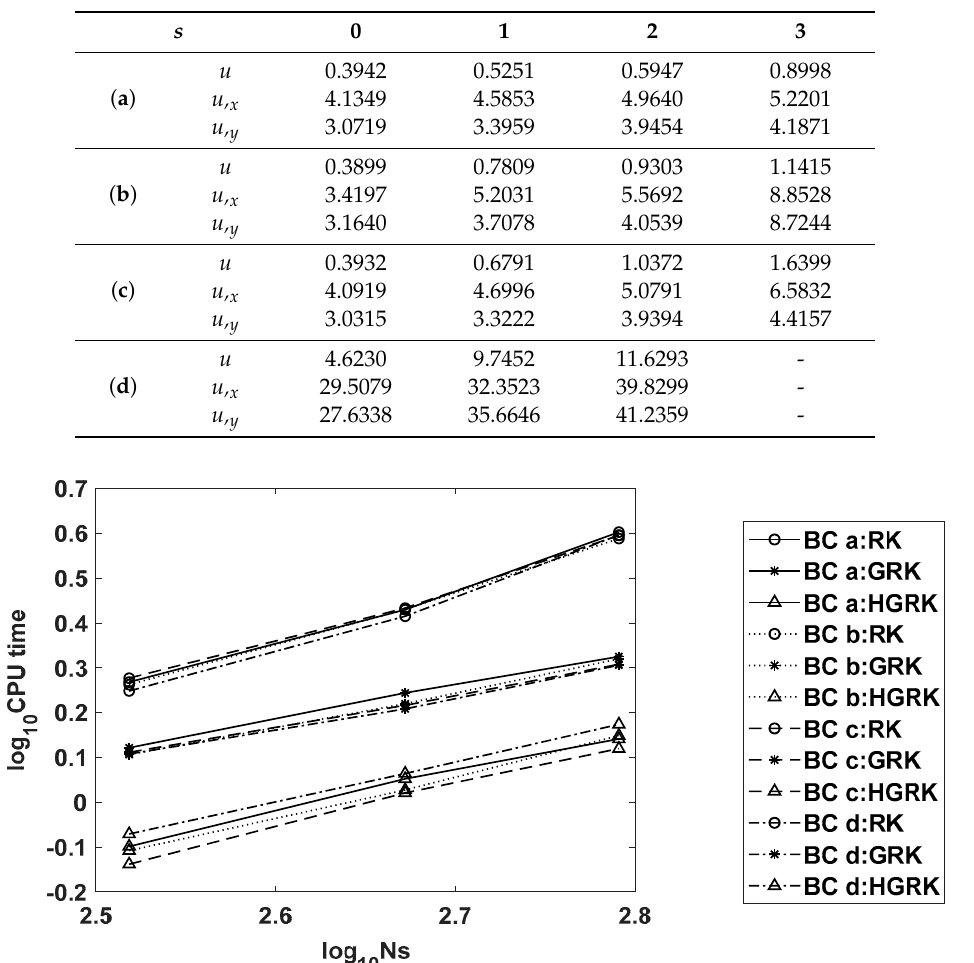
Table 2. Comparison of maximal absolute errors (%) obtained by various s : (a) half unknown inner boundary; (b) two half unknown inner boundaries; (c) unknown inner boundaries; (d) half unknown outer boundary.